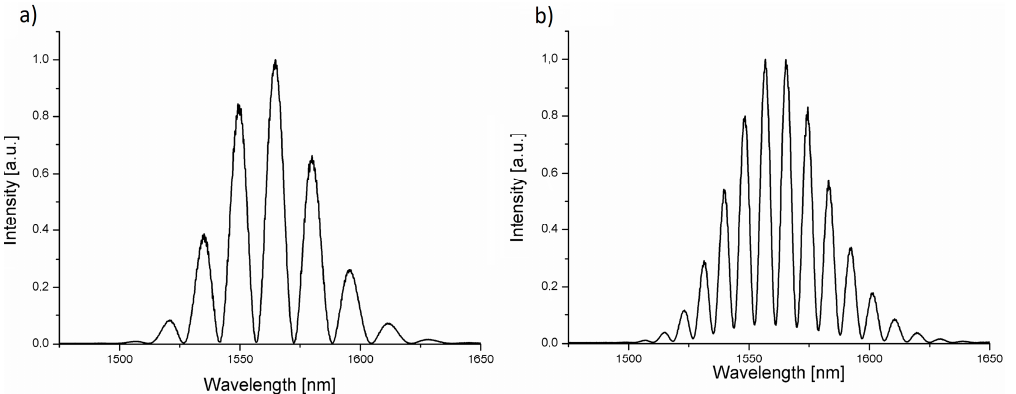
Figure 4. Signal measured with the central wavelength of 1550 nm for nitrogen-doped diamond (NDD) and the length of Fabry–Pérot cavity: ( a ) 80 µm; ( b ) 140 µm.